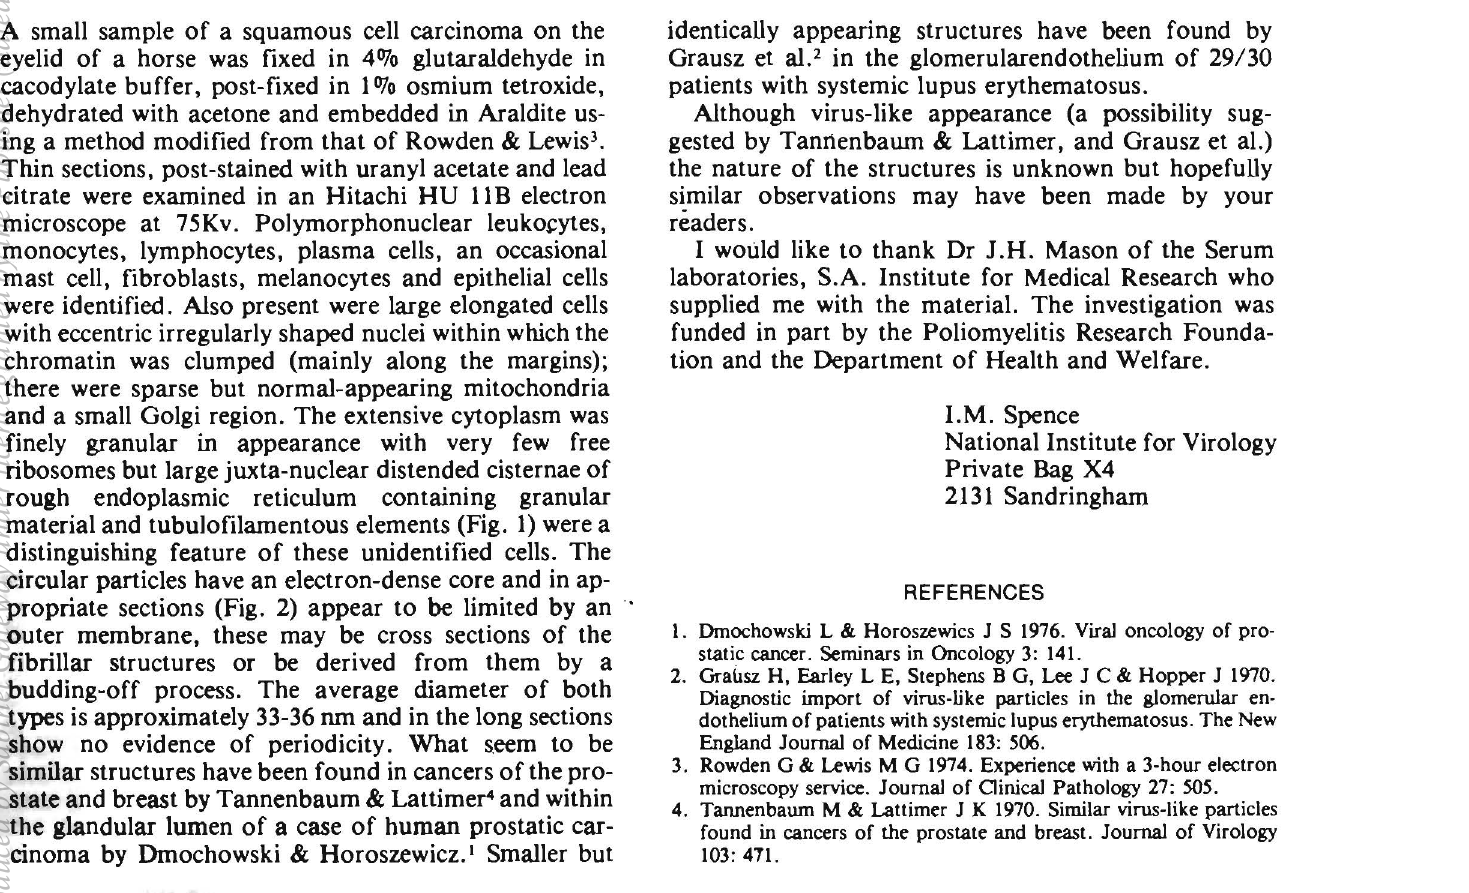
Fig. 1. Tubulolilamentous structures within cisternae 01 rough endoplasmic reticulum (i) Nucleus (N). x 43,400.